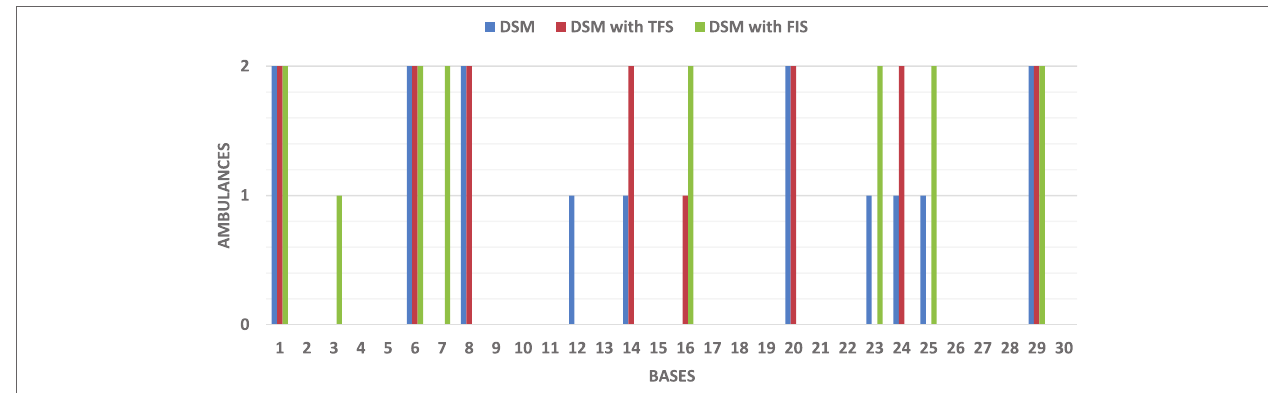
FigUre 11 | Comparison of number of ambulances located in each base with 15 available ambulances.